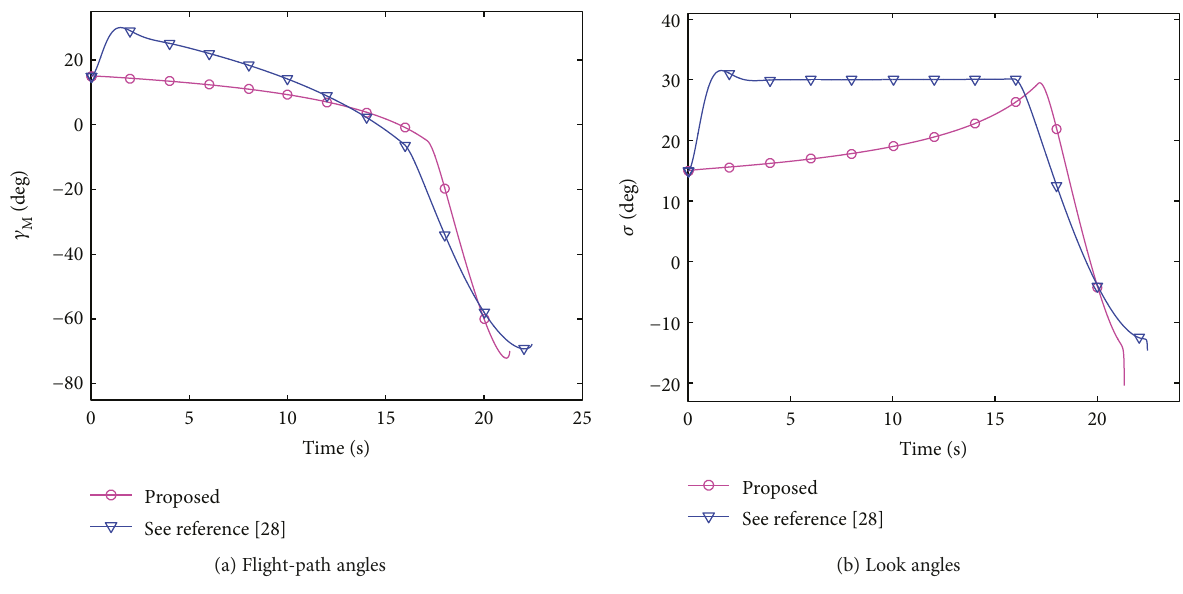
Figure 7: Comparative results with system lag T